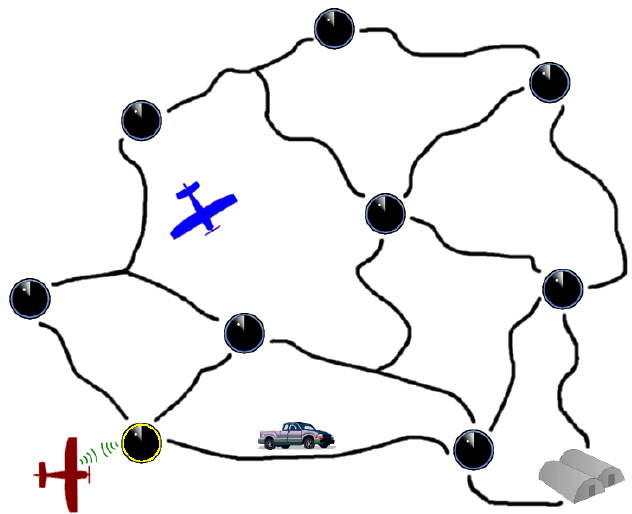
Figure 1. Cooperative surveillance and pursuit